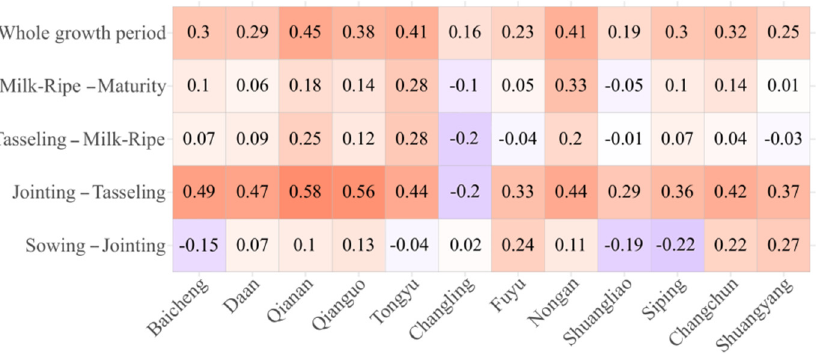
Figure 12. Pearson’s correlation coefficient of CWDI and Yw in maize growth period in midwestern Jilin Province.